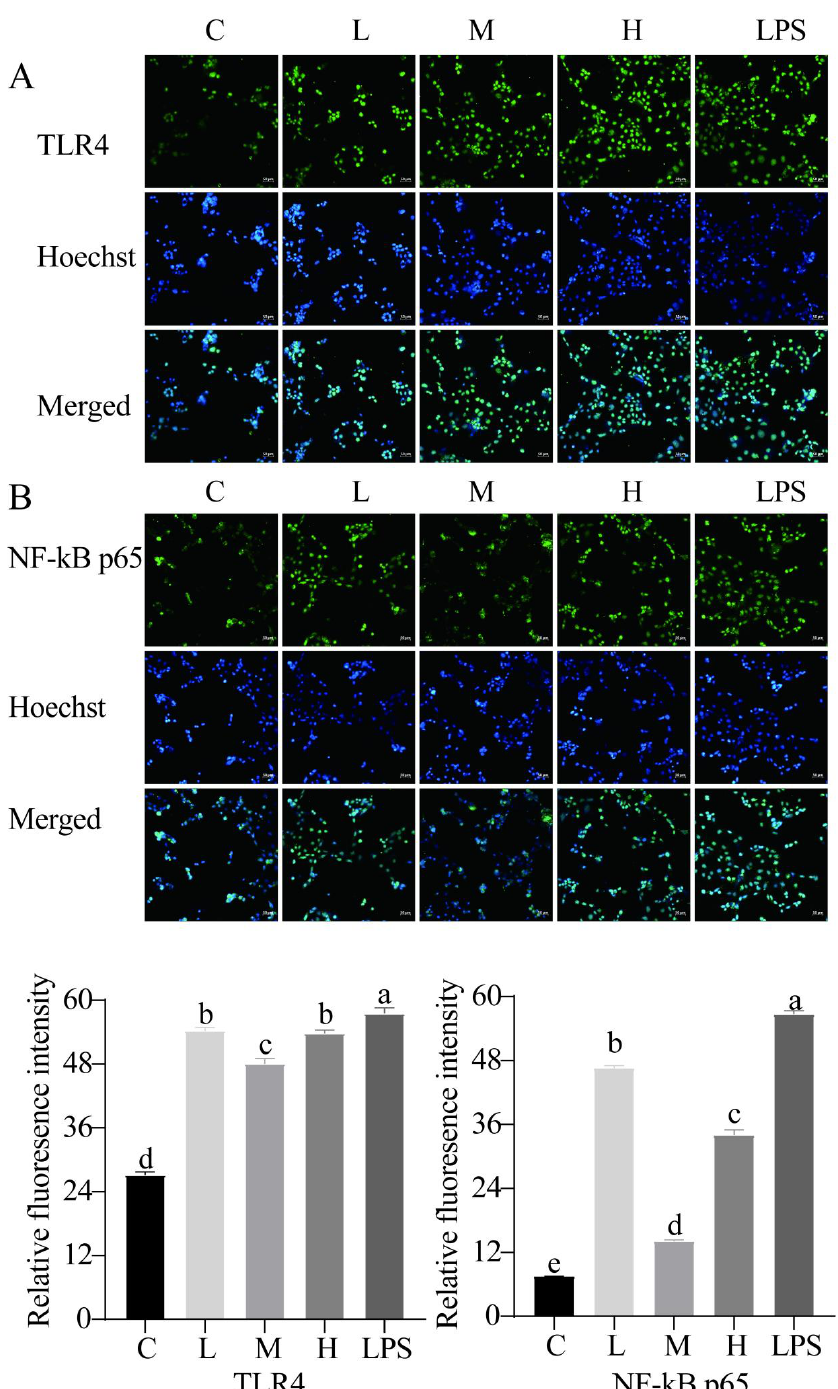
Figure 7. Effects of L. rhamnosus CY12 on the immunolocalization and relative fluorescence intensity of TLR4 and NF- κ B p65 in LPS-induced Caco-2 Cells. ( A ). TLR4. ( B ). NF- κ B p65. Note: C represents uninduced Caco-2 cells; L, M, and H represent LPS-induced Caco-2 cells co-incubated with 10 7 , 10 8 and 10 9 cfu/mL L. rhamnosus CY12, respectively; LPS represents LPS-induced Caco-2 cells. Data were presented as mean ± SEM. Means with the different letters are significantly different p < 0.05. The magnification of these picture is 100X, and scale bar is 50 µ